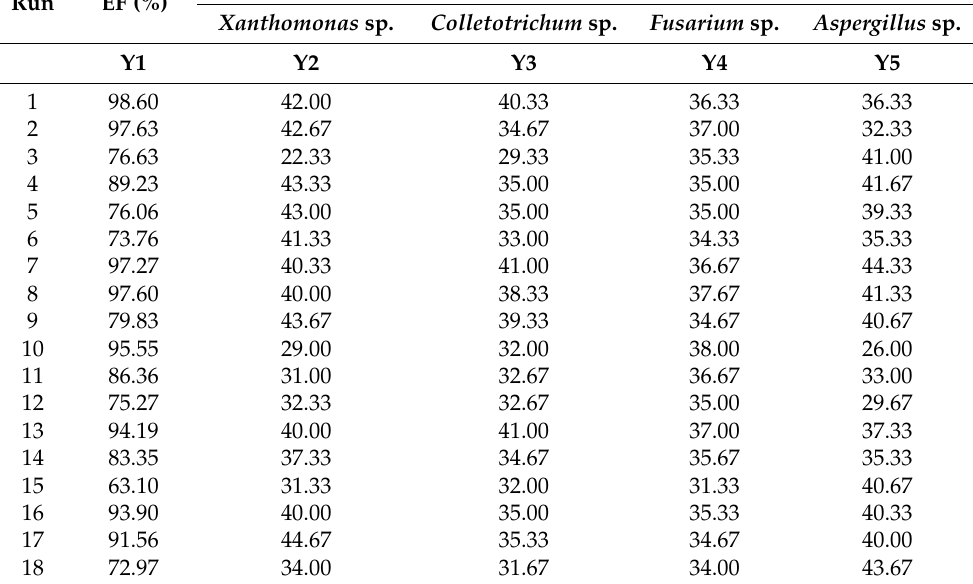
Table 6. Flocculation efficiency and precipitate antimicrobial activity results against the selected bacterial and fungal phytopathogens (L 18 array) during the flocculation of the Bacillus sp. BioSol021 cultivation broth. Antimicrobial Activity/Inhibition Zone Diameter (mm) Run EF (%) Xanthomonas sp. Colletotrichum sp. Fusarium sp. Aspergillus